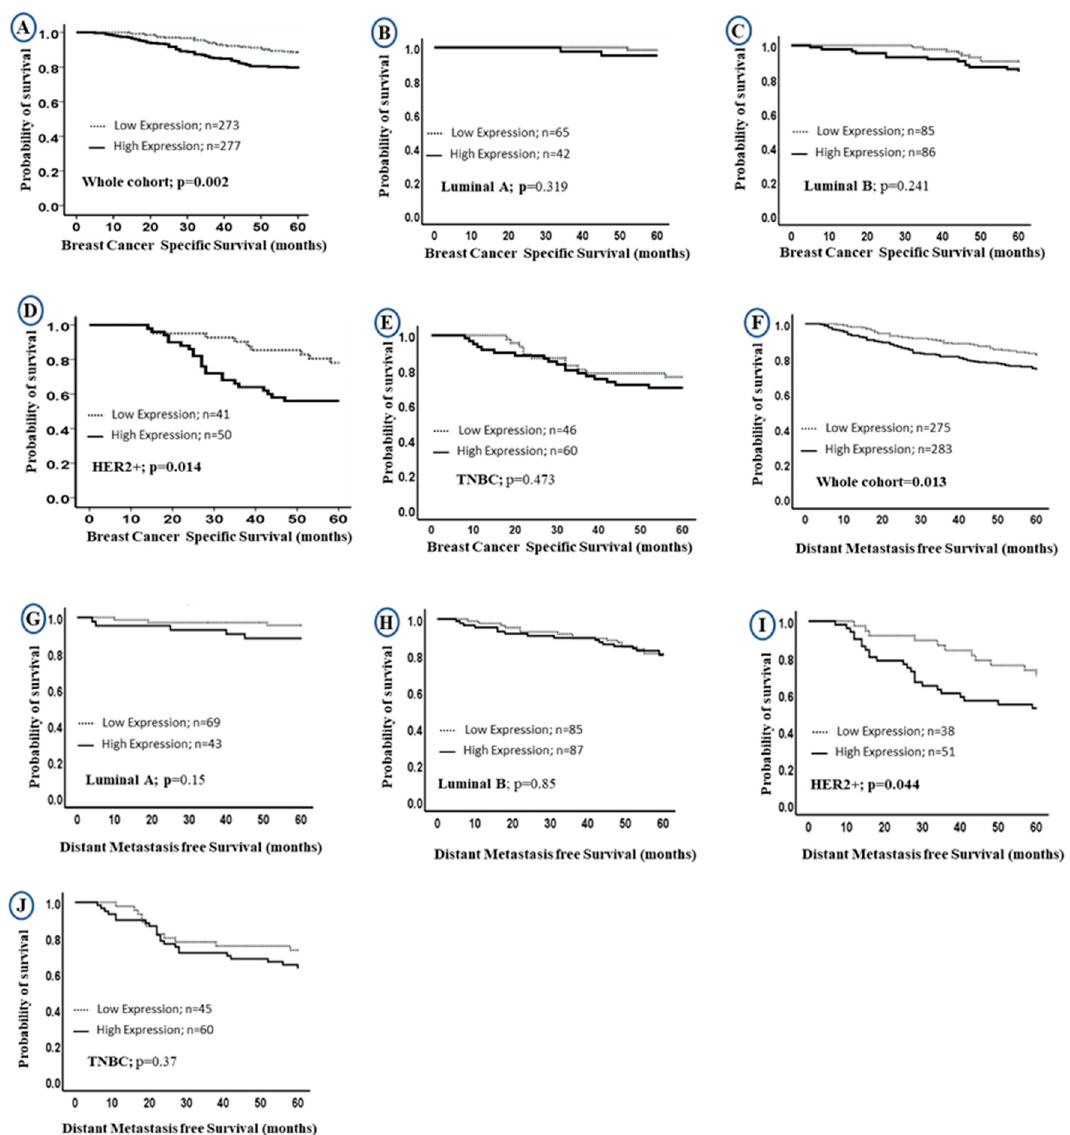
Figure 3. Kaplan-Meier curves of LAIR-1 protein expression and patient outcome: LAIR-1 protein expression and breast cancer (BC) specific survival (BCSS) ( A ) in the whole cohort, ( B ) Luminal A, ( C ) Luminal B, ( D ) HER2+ and ( E ) triple negative tumours (TNBC) BC subtypes. LAIR-1 protein expression and DMFS in ( F ) in the whole cohort, ( G ) Luminal A, ( H ) Luminal B, ( I ) HER2+ and ( J ) TNBC BC subtypes.